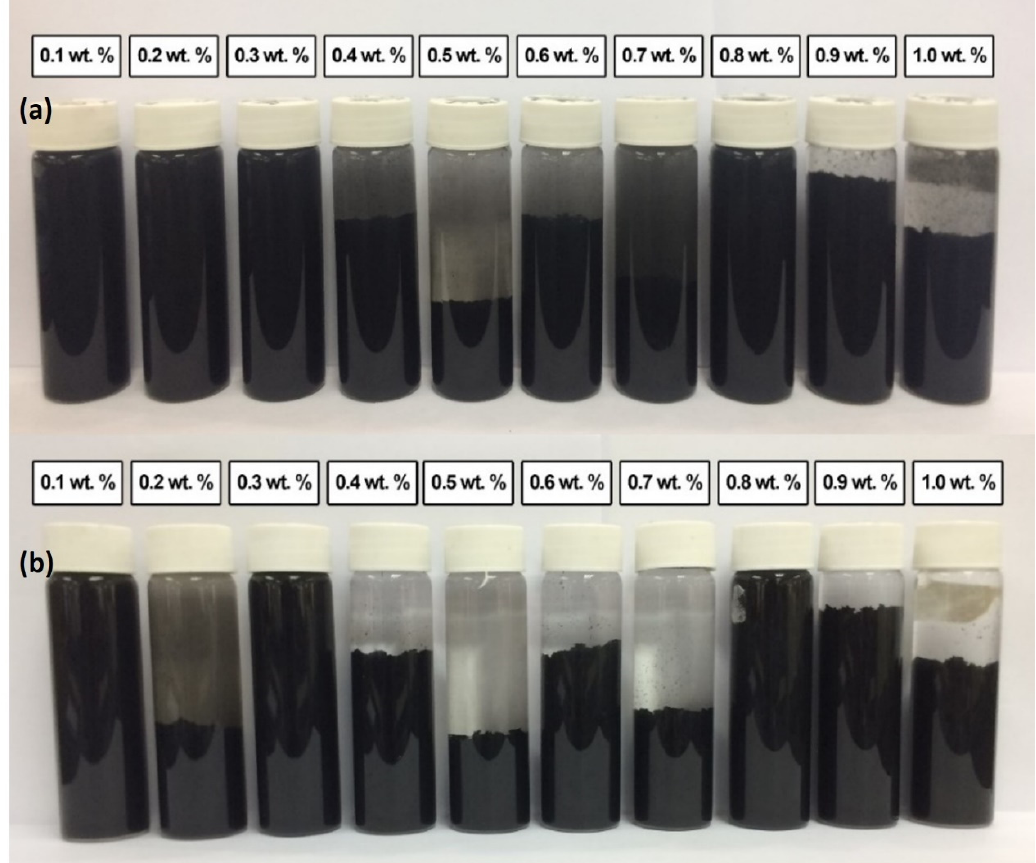
Figure 6. Stability and dispersion condition weight percentage of the commercial MWCNTs based nanofluid with surfactant of PVP for ( a ) 0.5 h; ( b ) 100 h after homogenization and sonication process.